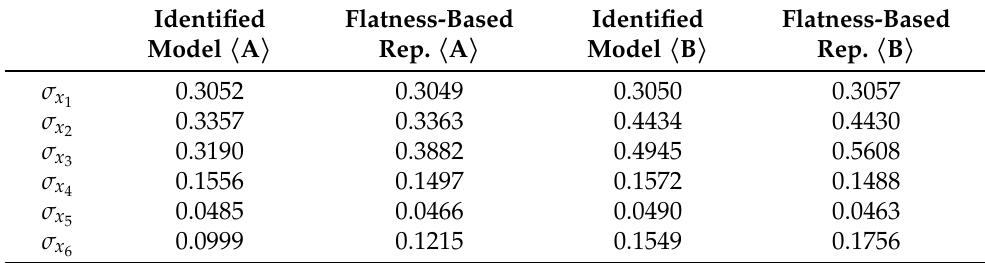
Table 1. Comparison of the standard deviations of the disturbance estimate H ( t ) · for both types of input parameterization (input representation according to the identified model according to Section 2.3.1; flatness-based representation according to Section